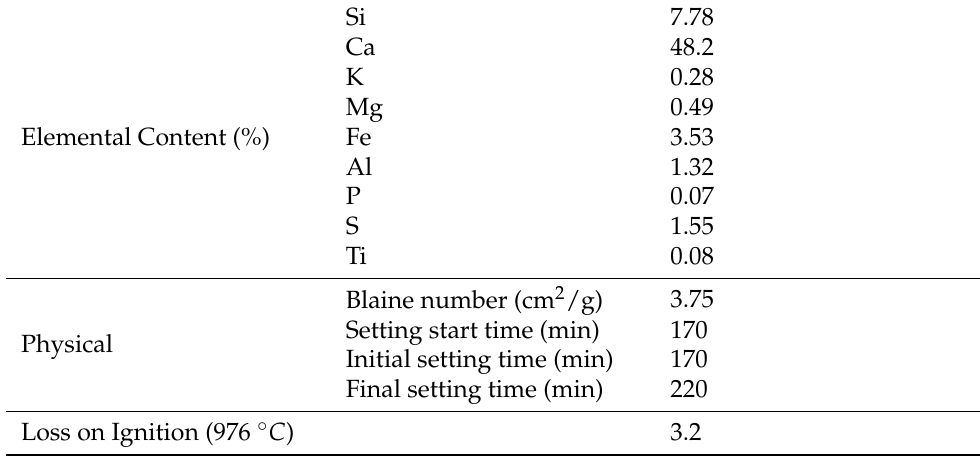
Table 2. Elemental composition (wt.%) of source cement and physical-chemical properties (according to the supplier).